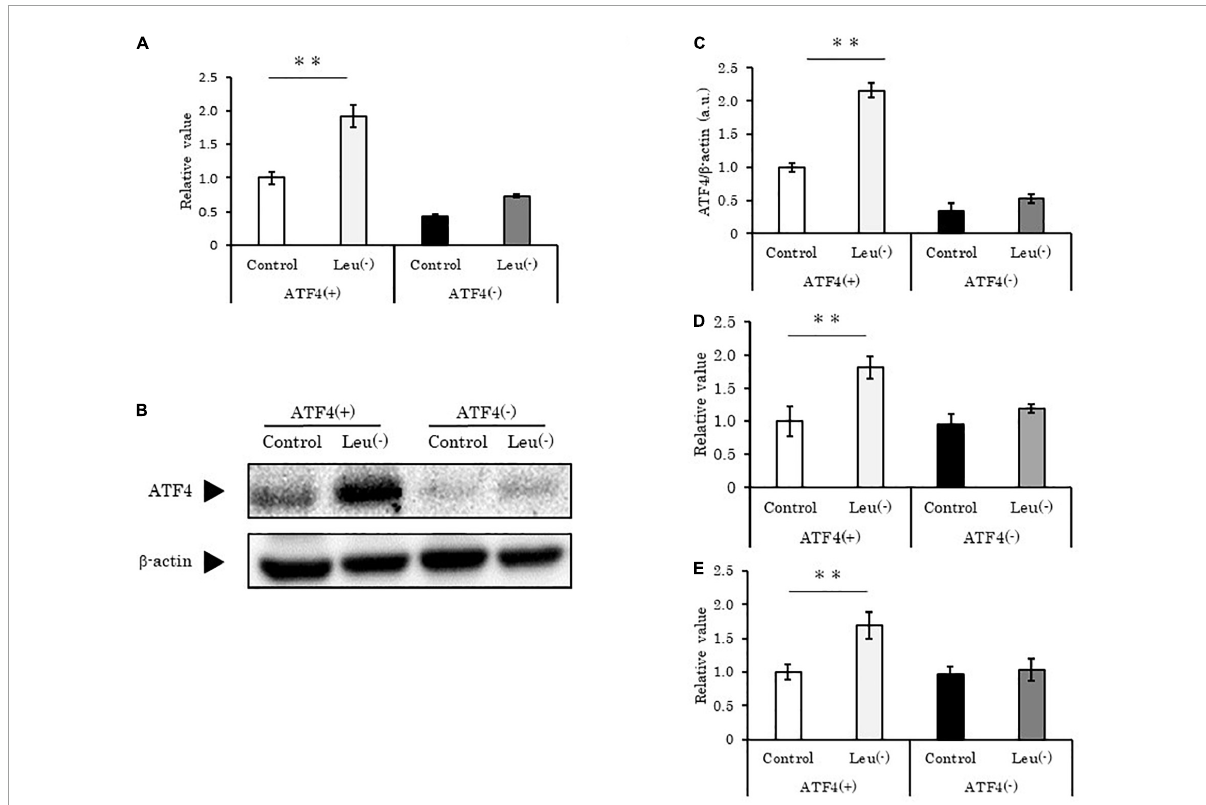
FIGURE2 Activating transcription factor 4 knockdown suppresses hsa-miR-663a and hsa-miR-1469 induction under leucine deprivation in HepG2 cells. (A) HepG2 cells transfected with ATF4 -specific siRNA for 12 h, followed by 12 h of leucine deprivation, and then analyzed using PCR for ATF4 mRNA level. (B) HepG2 cells were treated as in panel (A) and analyzed using western blotting for ATF4 and β -actin protein levels. (C) Quantification of ATF4/ β -actin as described in panel (B) . (D,E) HepG2 cells were treated as in panel (A) and analyzed using PCR for (D) hsa-miR-663a and (E) hsa-miR-1469 levels. Data are mean ± SE of three independent experiments. * p < 0.05 and ** p < 0.01, vs. Control. Leu (-), leucine deprivation; ATF4, activating transcription factor 4; ATF4(+), HepG2 cell with normal expression of ATF4; ATF4(-), HepG2 cell with ATF4 expression knocked down.